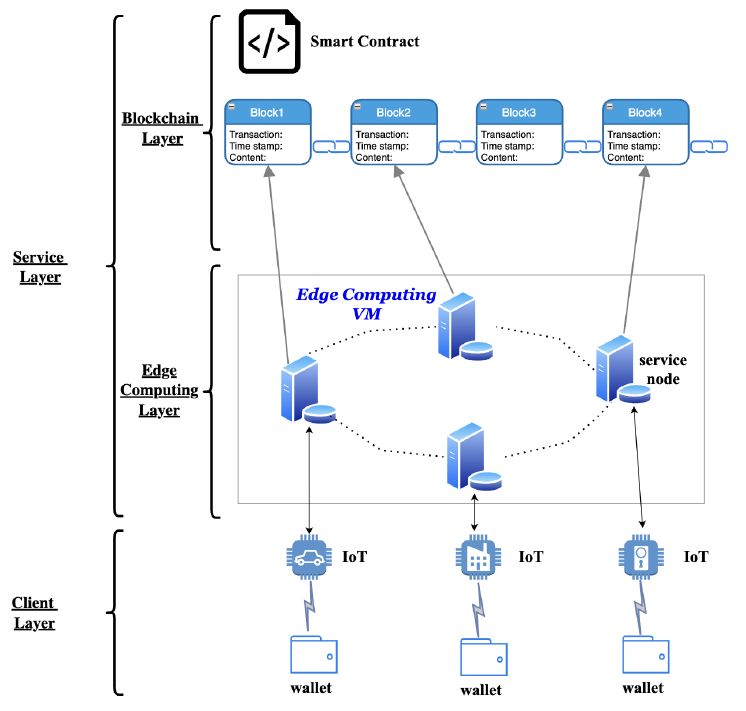
Figure 1. Blockchain-based MEC system